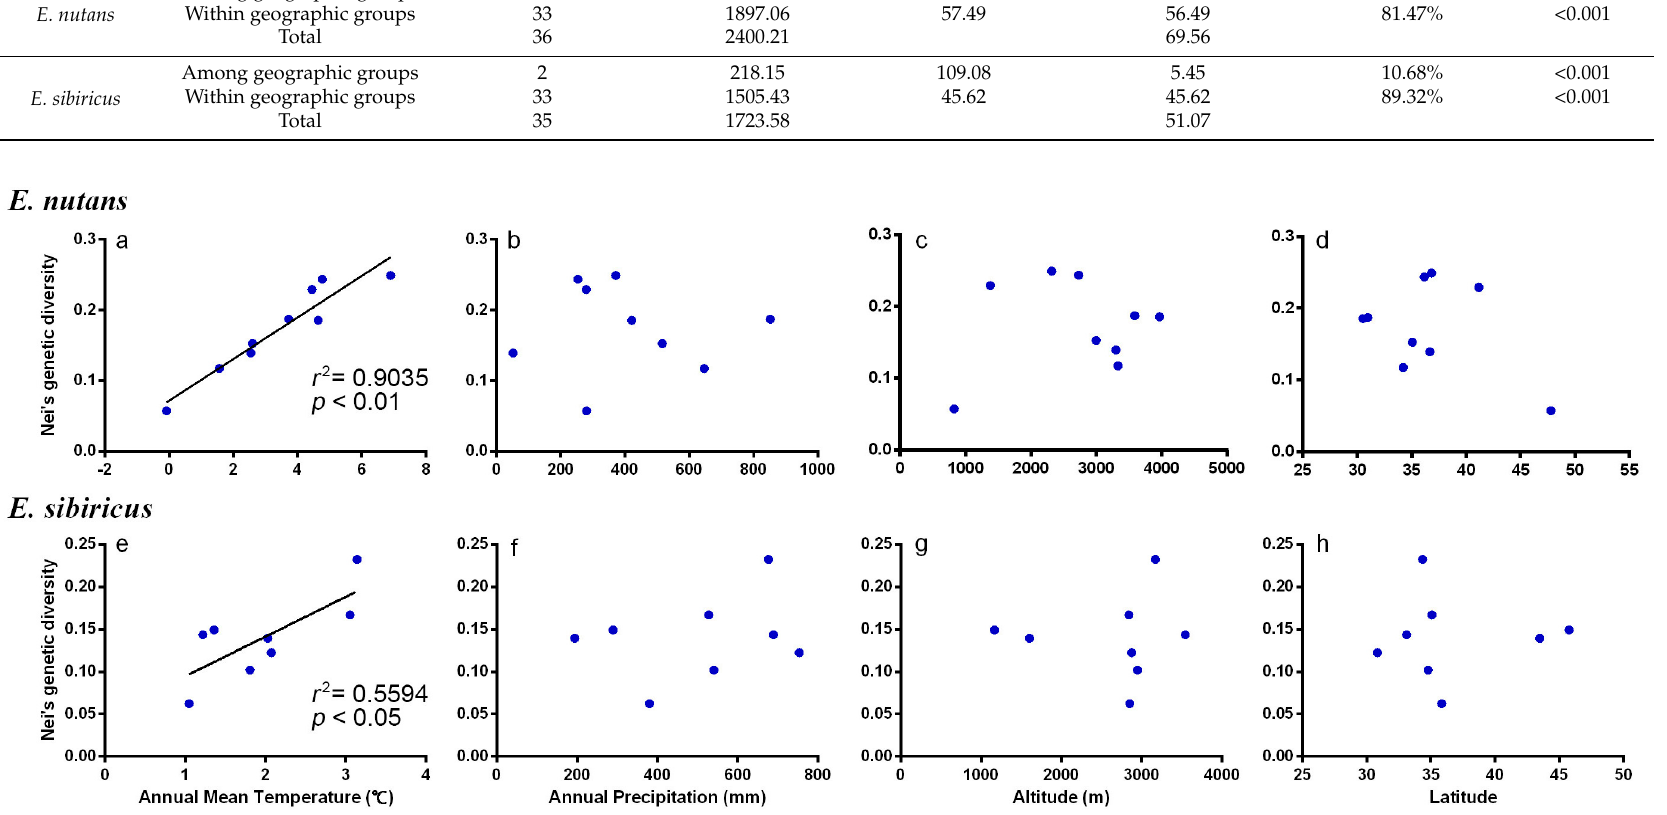
Figure 5. Regression analysis between Nei’s genetic diversity (H) and environmental factors for E. nutans and E. sibiricus . A regression line was fitted only for analyses with p < 0.05.